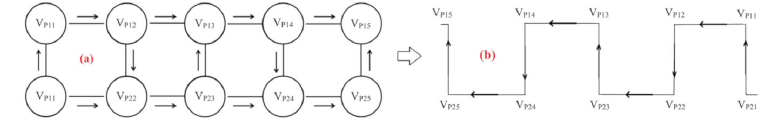
Figure 10. Trajectory optimization. ( a ) vertices of the square wave; ( b ) trajectory of square wave.